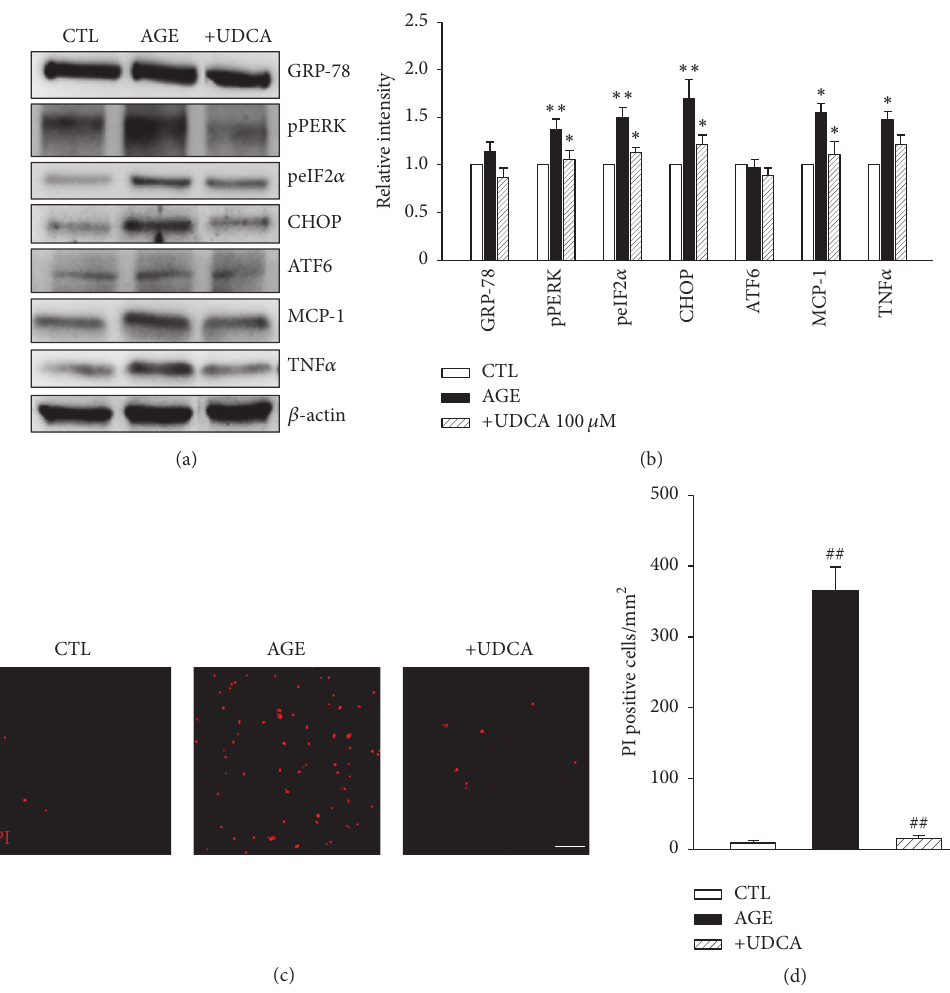
Figure 5: AGE-induced UPR, inflammatory cytokine expression, and cell death are attenuated by UDCA in retinal pericytes. (a) Typical results of five independent western blots are shown. (b) Increase in pPERK, peIF2 𝛼 , CHOP, and MCP-1 was attenuated upon cotreatment with UDCA. GRP78, ATF6, and TNF- 𝛼 did not display significant changes in expression among groups. (c, d) PI staining demonstrating a protective effect of UDCA against cell death in AGE-exposed retinal pericytes. Original magnification: × 100; scale bar: 100 𝜇 m. CTL: control pericytes, AGE: AGE-exposed pericytes, and +UDCA: AGE-exposed pericytes cotreated with UDCA, ∗ 𝑃 < 0.05, ∗∗ 𝑃 < 0.01, ## 𝑃 <